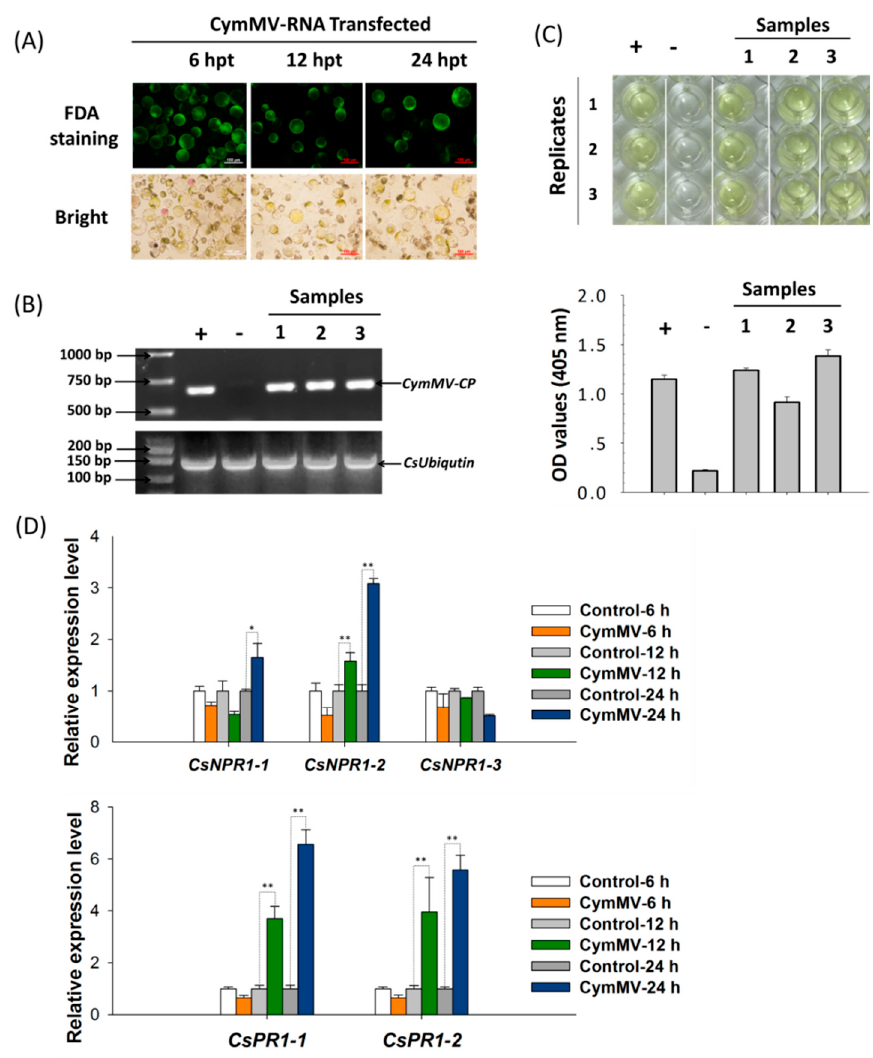
Figure 6. Expression analyses of CsNPR1 and CsPR1 genes in response to CymMV infection by qRT-PCR. ( A ) Cymbidium protoplasts were transfected with the in vitro transcripts of entire CymMV-RNA, and the viability of transfected protoplasts were examined by FDA staining; ( B ) the replication of CymMV in Cymbidium protoplasts were confirmed by RT-PCR with three replicates; ( C ) the replication of CymMV in Cymbidium protoplasts was confirmed by DAS-ELISA with three replicates; ( D ) the relative expression levels of CsNPR1 and CsPR1 genes in transfected protoplasts were measured by qRT-PCR; Y-axes indicate the relative expression levels; significant difference was assessed by Mann–Whitney U-test and indicated by asterisks; single asterisk (*) represents p ≤ 0.05, double asterisk (**) represents p ≤ 0.01; data are expressed as the mean of three biological replicates, with error bars indicating the SD.